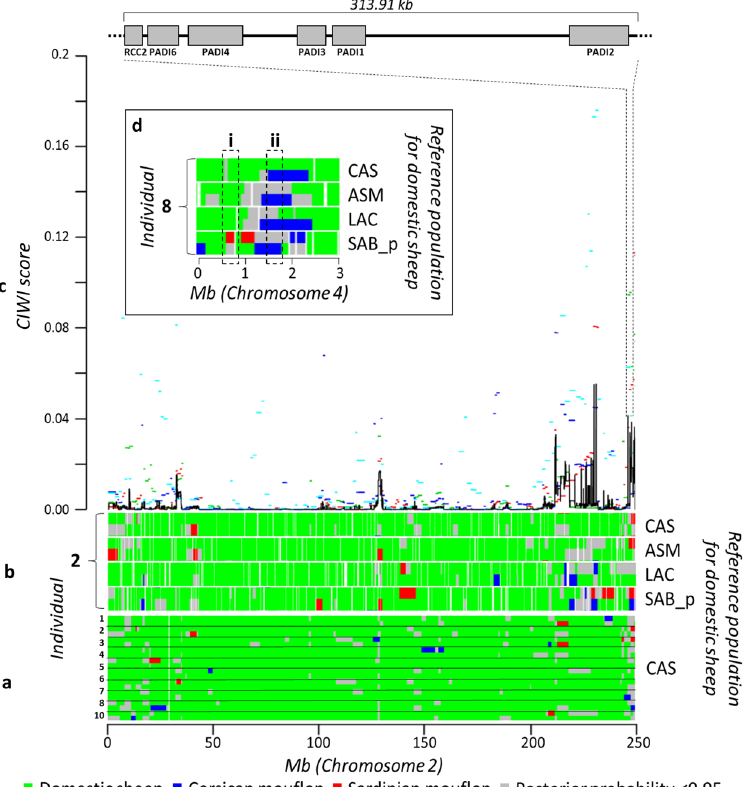
Figure 4. Graphical exemplification of the CIWI approach. Graphical representation of the inferred local ancestry for a domestic sheep breed (SAR) according to PCAdmix. ( a ) The 10 focal diploid individuals belonging to SAR are represented by the 10 numbered lines. Each line represents a diploid individual of the SAR population, and extends for the total length of the ovine chromosome 2 (249.99 Mb). The colour scheme indicates the assignment of each block to one of the three reference populations. ( b ) PCAdmix results for one individual (number 2) of the SAR population, obtained from comparison with four different reference populations for domestic sheep (CAS, ASM, LAC, SAB_p). Genomic regions not analysed by the software due to the absence of SNPs are visible as white gaps. ( c ) Within-analysis concordance scores (A-scores) are calculated along the chromosome to represent the concordance of ancestry assignment among the 10 focal SAR individuals. The A-scores relative to the four reference populations are represented by coloured segments. The CIWI score is then calculated from the A-scores and is represented by the black solid line. The inset expands the genomic region within chromosome 2, where genes related to the citrullination function are located. ( d ) Comparison between PCAdmix results for a portion of chromosome 4 in the same individual when compared to four different domestic sheep reference populations. Regions of discordance (i) and concordance (ii; a CIWI) are highlighted by dashed